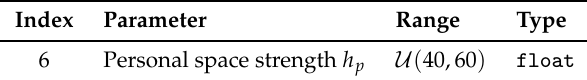
Table 2. Alternative range for the personal space strength parameter.